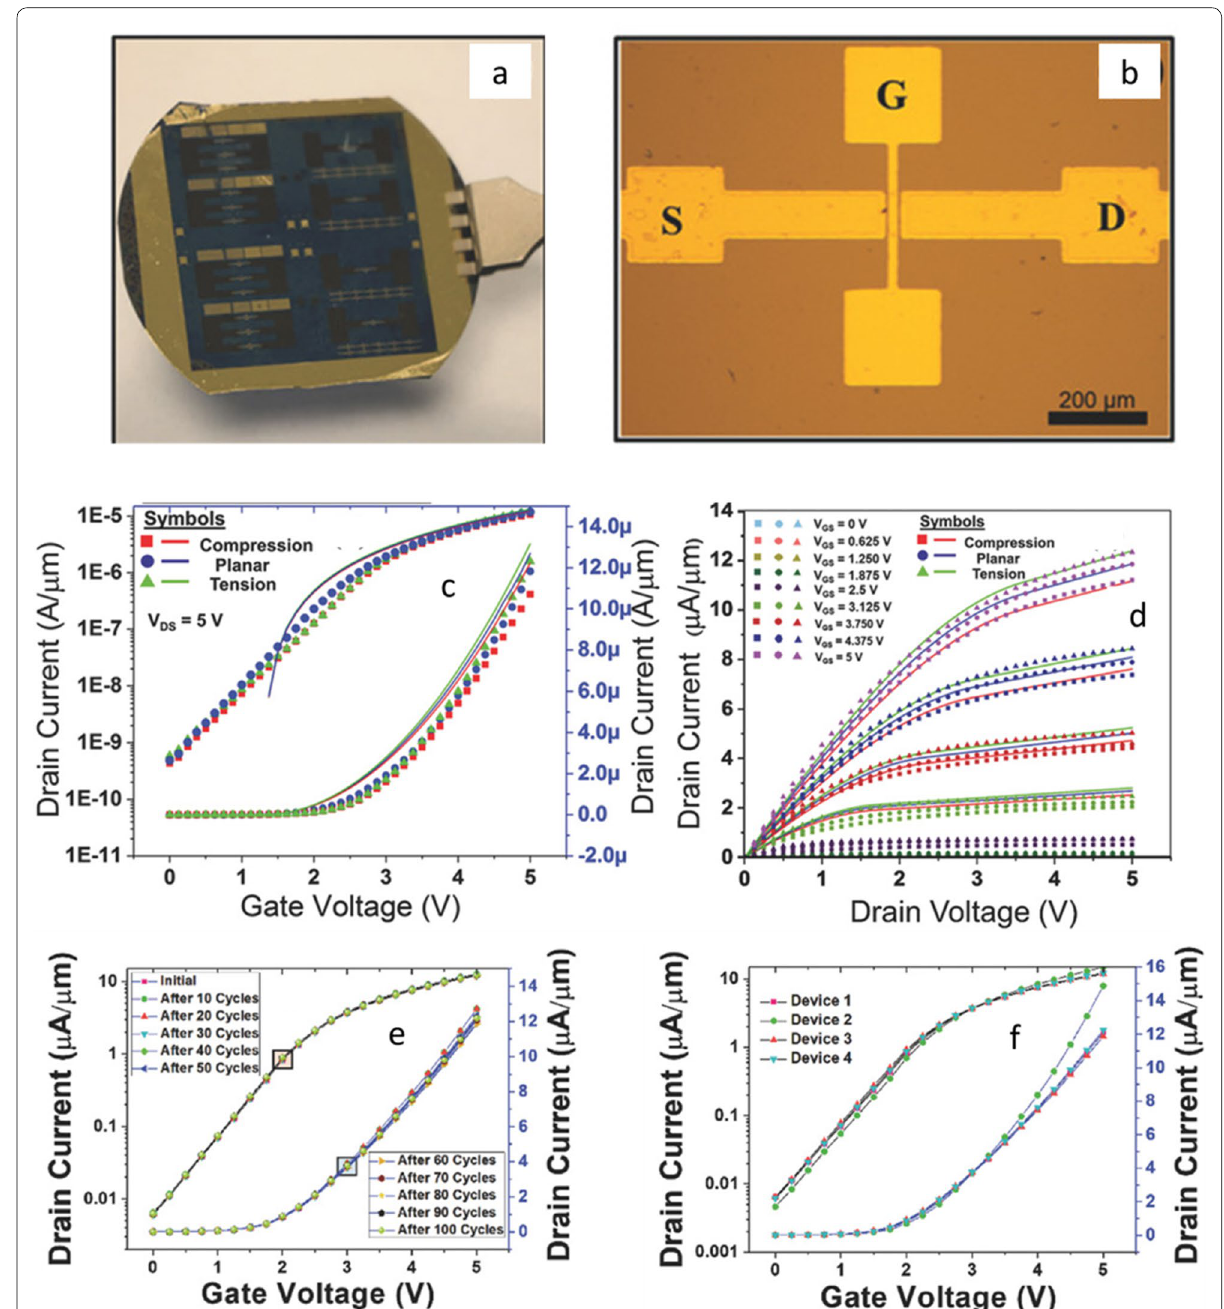
Fig. 10 a Digital image and ( b ) microscopic image of n-MOSFET. Transistor performance: ( c ) transfer and ( d ) output characteristics of n-MOSFET under various bending strain, ( e ) transfer characteristics under cyclic bending, and ( f ) reliability test with device to device variation. Reprinted with permission from Ref [26]. Copyright (2018)